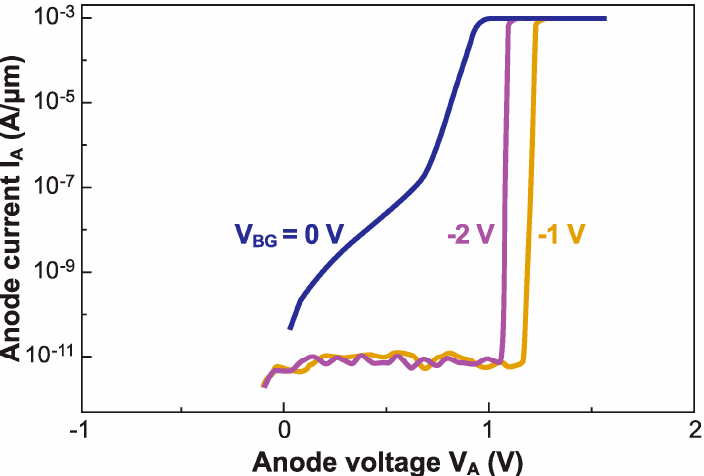
Figure 8. Output characteristics of a Z 2 –FET for variable voltage applied to the ground plane. V FG = 1.5 V, other parameters as in Figure 4 (adapted from [27]).